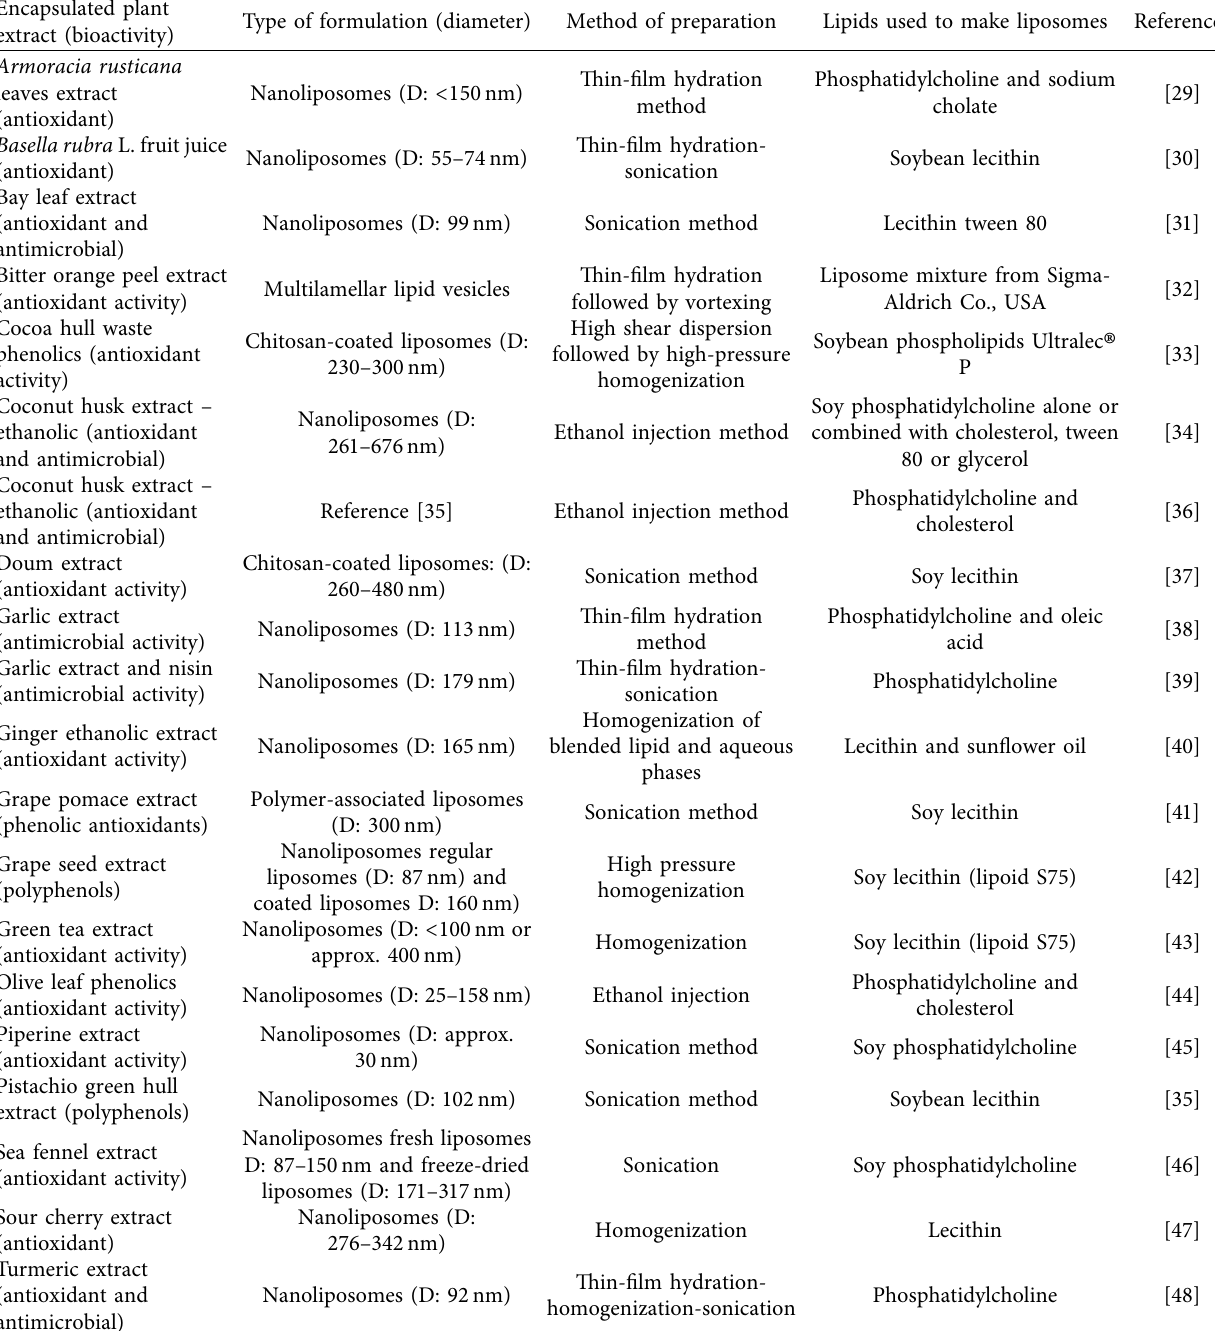
Table 2: Recently reported plant extract encapsulated liposomal formulations with potential applications in food, methods of preparation, and lipids